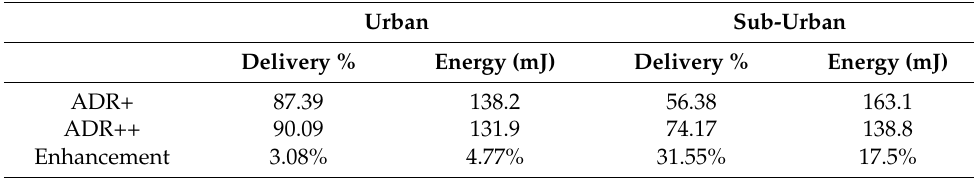
Figure 5. Simulation comparison between ADR+ and ADR++ at α BEST with different number of nodes in sub-urban scenario: ( a ) delivery ratio; ( b ) energy consumed. The summary of performance improvement of ADR++ at α = α BEST shown in Table 5. Table 5. Numerical results from ADR+ and ADR++ and enhancement ratio in both scenarios obtained when number of nodes N =